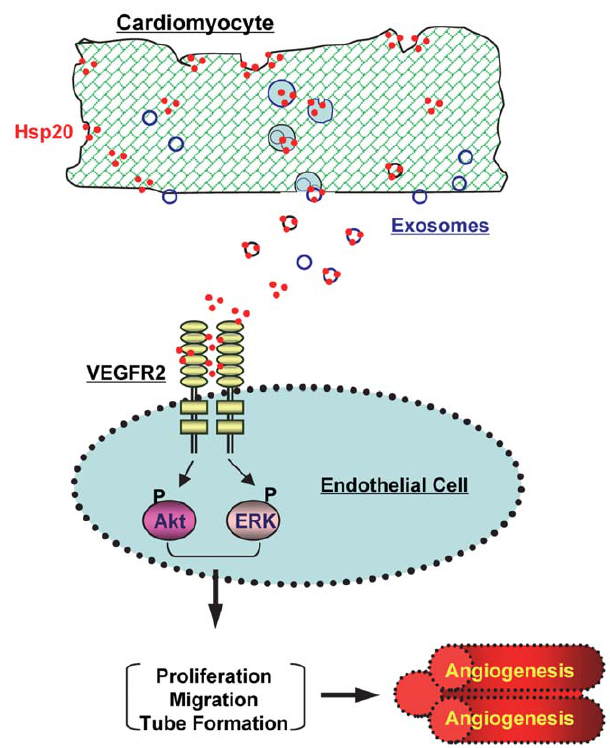
Figure 7. Proposed mechanism of the Hsp20 release and its regulation of myocardial angiogenesis. Intracellular Hsp20 is released outside cardiomyocytes via exosomes, and then interacts with VEGFR2. Consequently, its downstream signaling pathways (i.e. Akt and ERK) are activated, which promote myocardial angiogenesis.